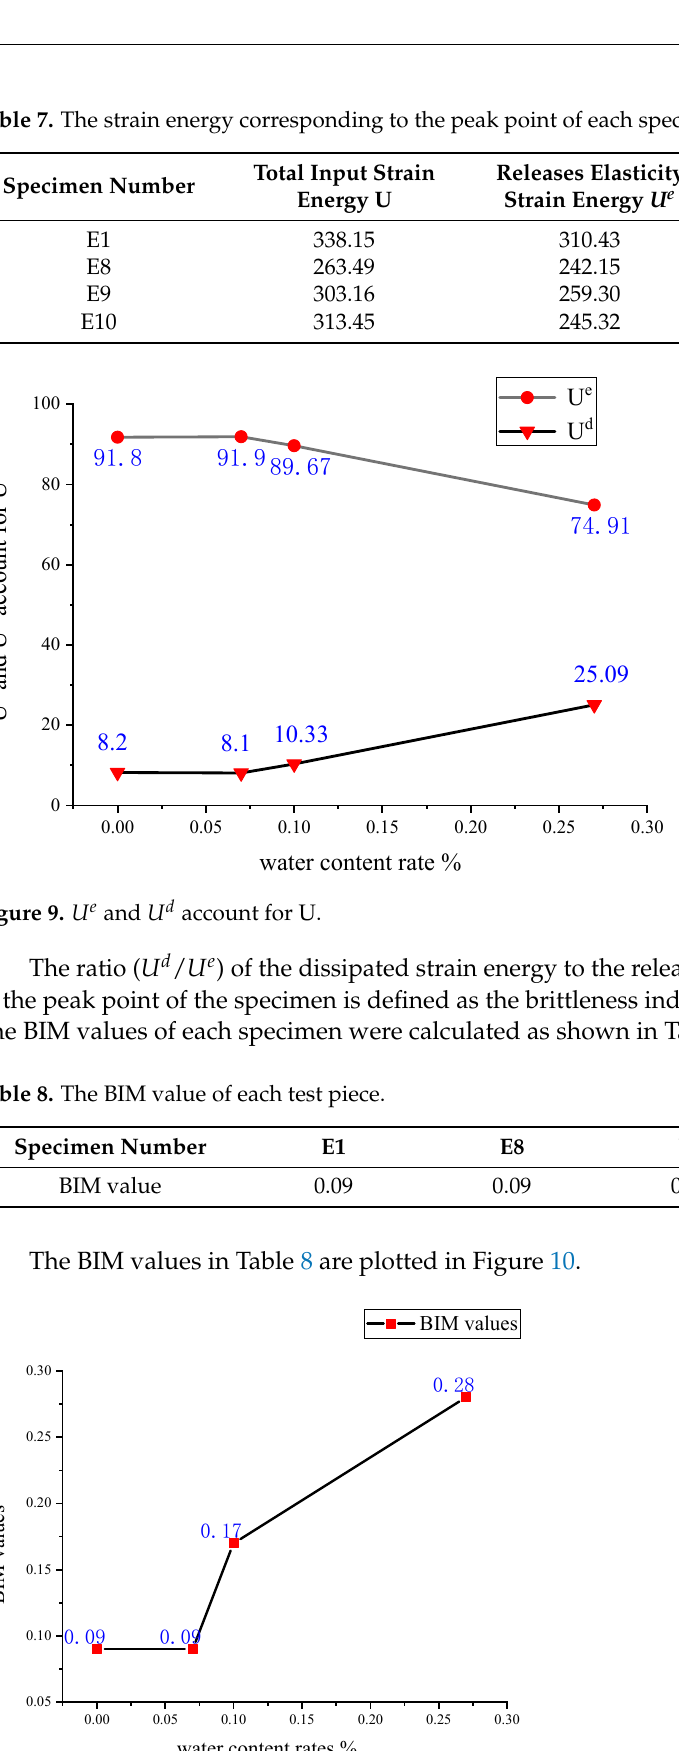
Table 8. The BIM value of each test piece.